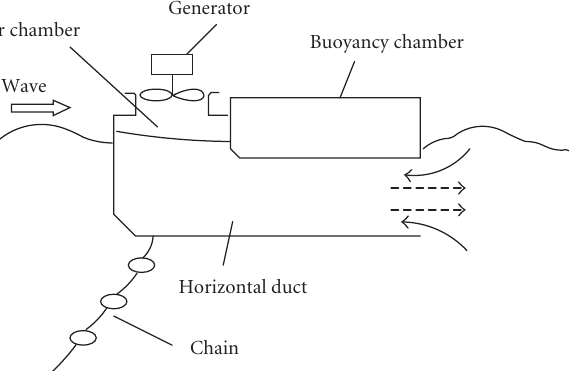
Figure 10: Floating-type OWC device “Backward Bent Duct